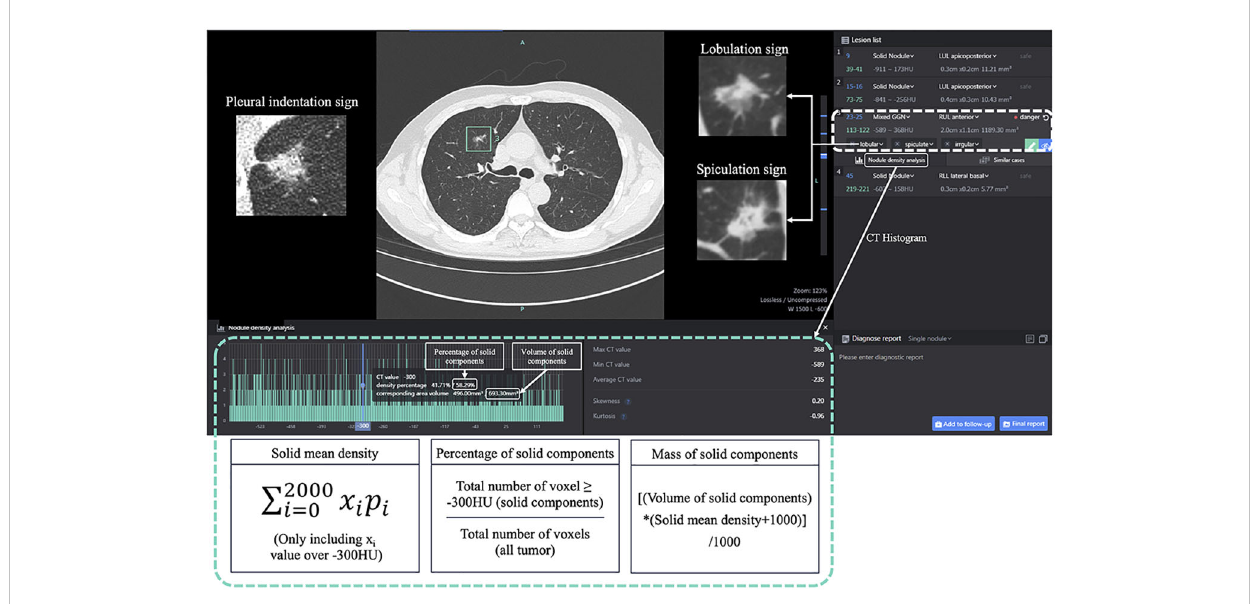
FIGURE 2 The CT histogram parameters using InferRead CT Lung, an AI-based pulmonary nodule auxiliary diagnosis system. Mixed GGN, mixed ground-glass